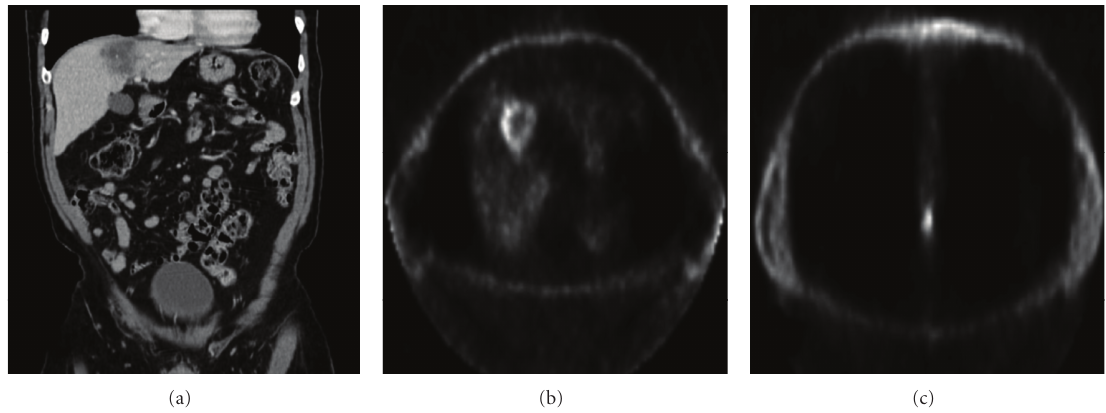
Figure 1: CT (a) and PET (b) showing hepatic metastasis, and (c) PET showing anal